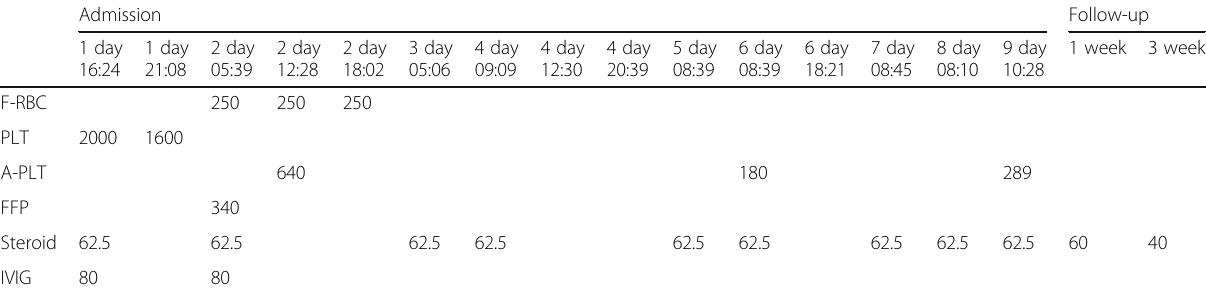
Table 1 Laboratory value of the patient